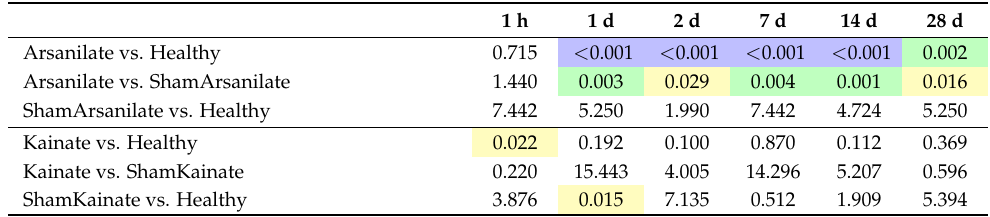
Table A5. Bonferroni-corrected p values for average tilt point angle to xz plane during immobility (one- sided Mann–Whitney U test; p values lower than 0.05, 0.01 and 0.001 are highlighted in yellow, green and blue, respectively).